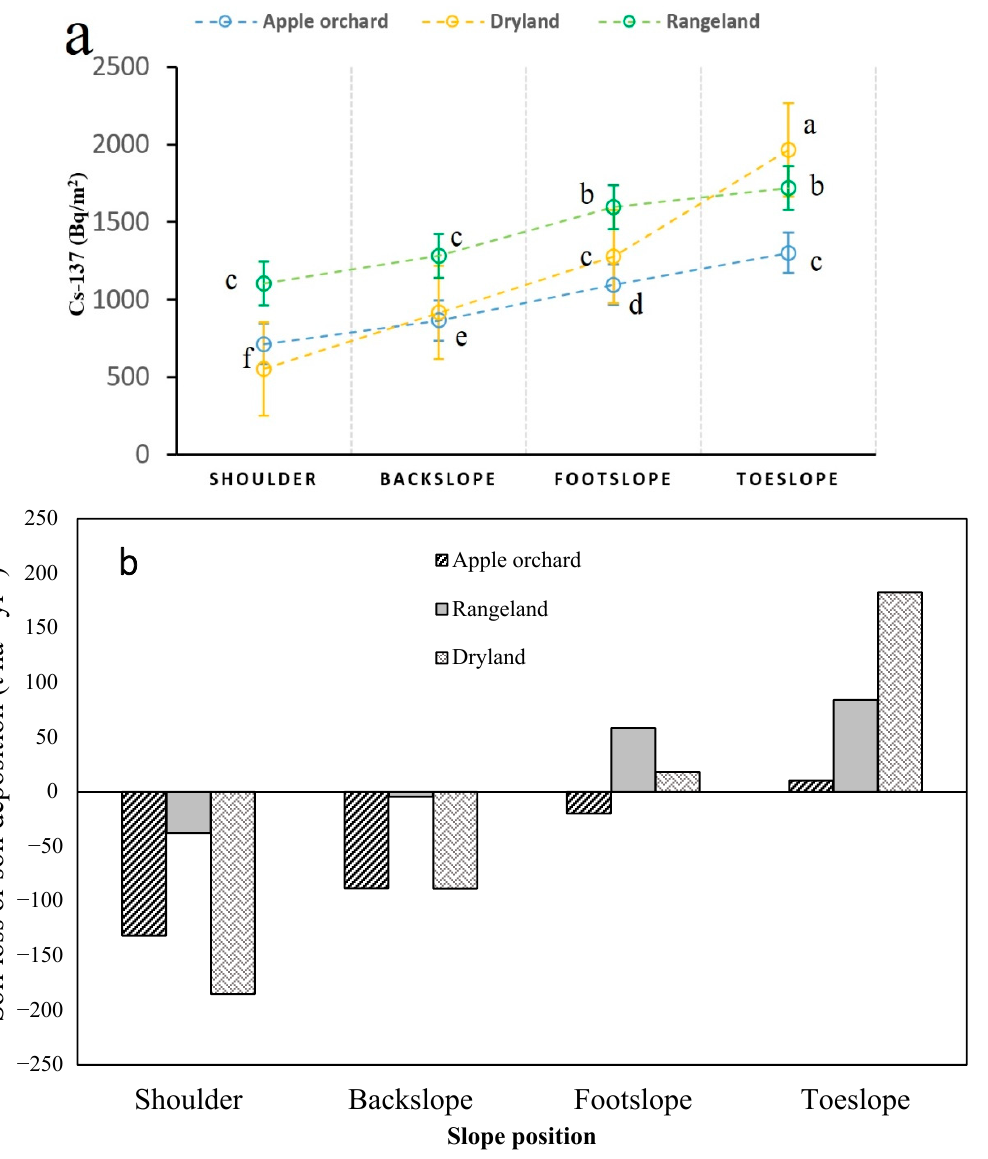
Figure 5. Variability in magnetic susceptibility ( χ lf ) at three land uses in four slope positions, means with the same letter are significantly different using the least significant difference (LSD) test at p < 0.01 ( a , b ) the relationship between χ lf and χ fd for all studied soil samples.